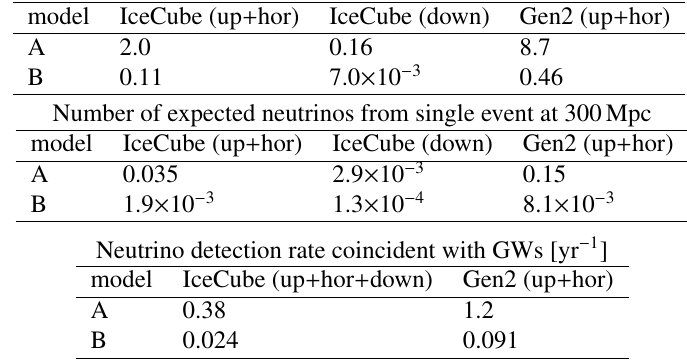
Table 5. Detection probability of neutrinos coincident with GWs by IceCube and IceCube-Gen2 (Gen2). “up + hor” means the up-going and horizontal events. “down” means the down-going events. Since the e ff ective area of the down-going events with IceCube-Gen2 is very uncertain, we avoid discussing it. This table is adapted from